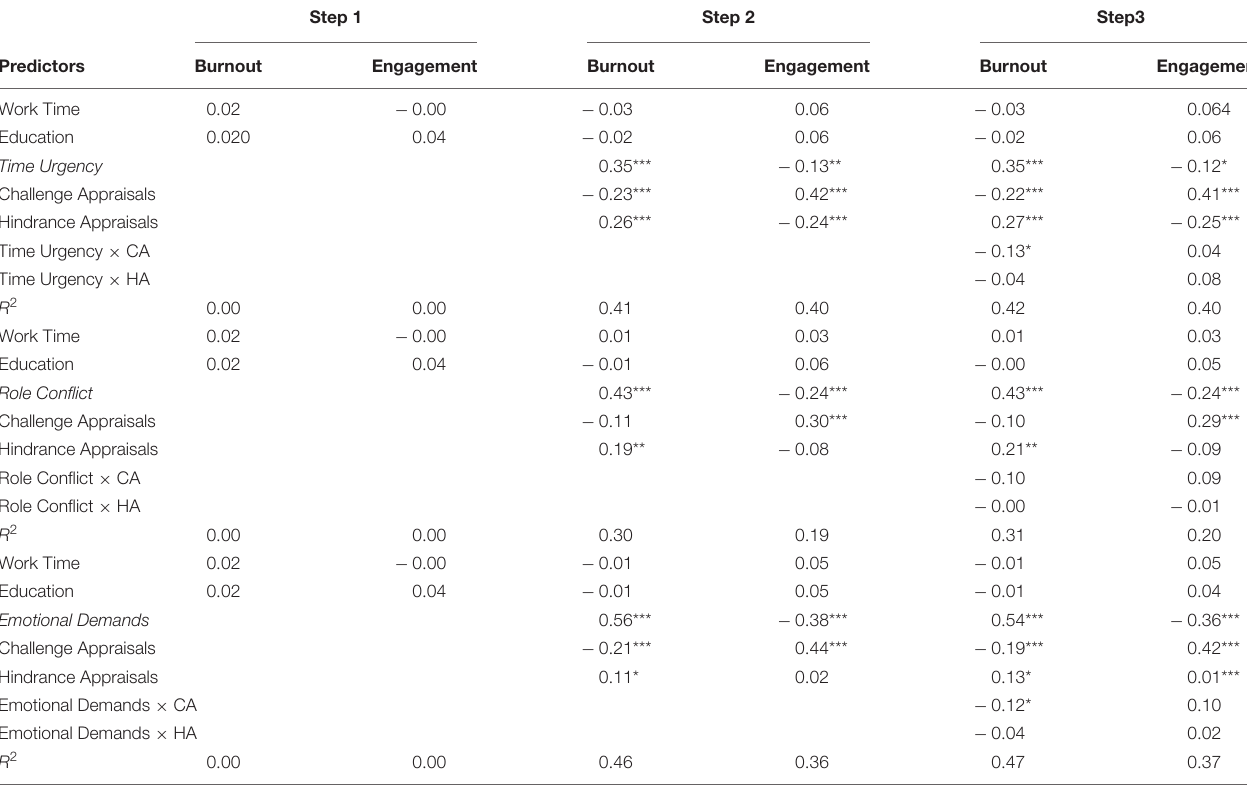
TABLE 7 | Regression results for the moderation of appraisals on the relationships between job demands and work engagement/burnout in Study